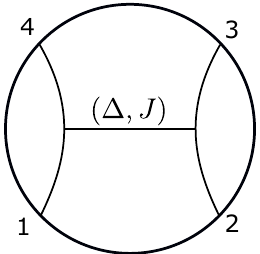
Figure 2 . Exchange Witten diagram. We consider the contribution of the exchange Witten diagram to the four-point